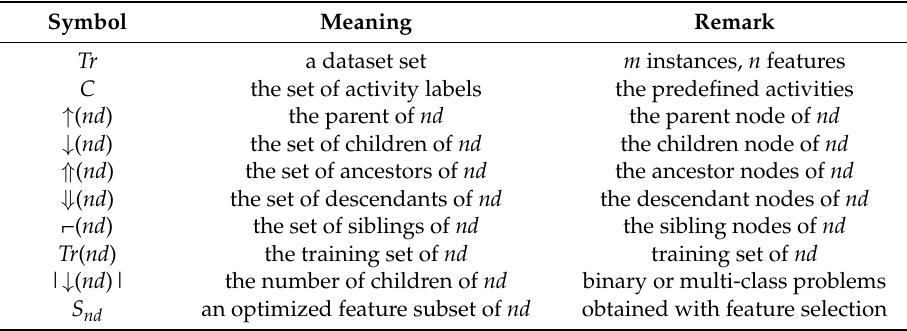
Table 1. Notation and corresponding meaning.